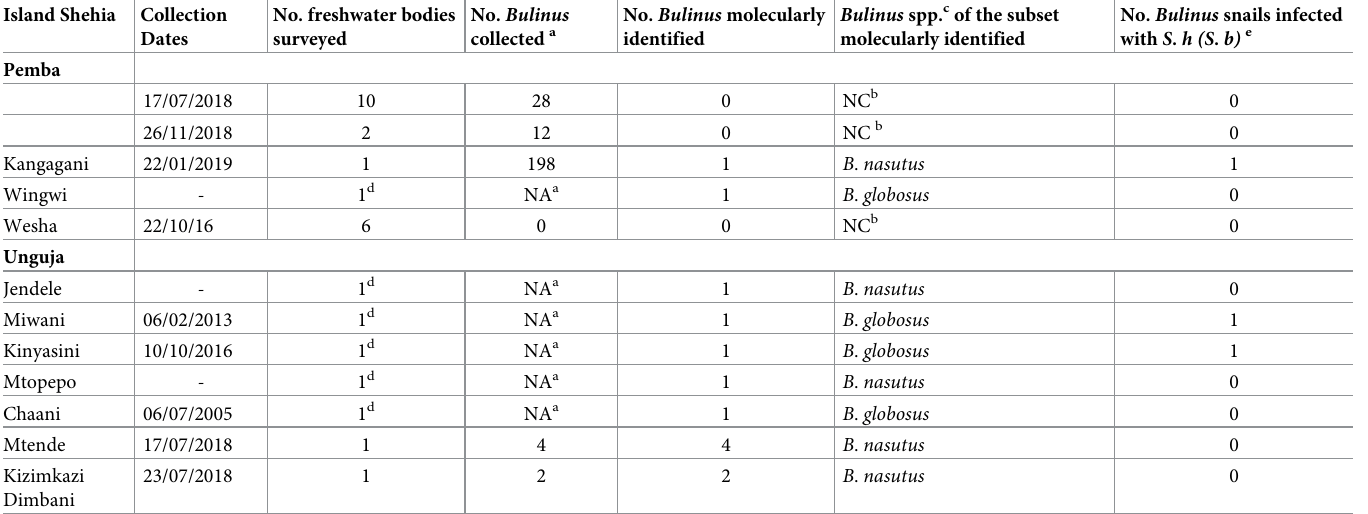
NC indicates that no snails were either collected or identified during these surveys. c Species inferred from cox 1 similarity to reference sequences.